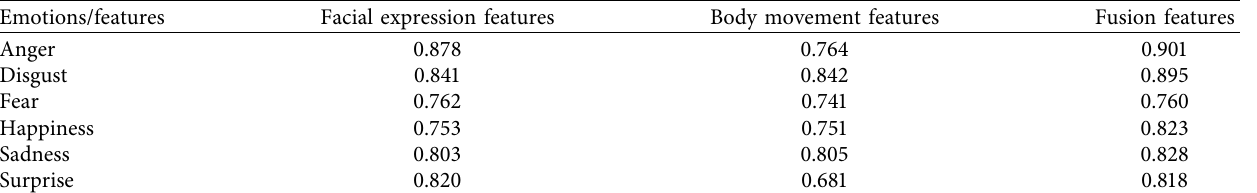
Table 4: Experimental results of emotion recognition based on body movements.